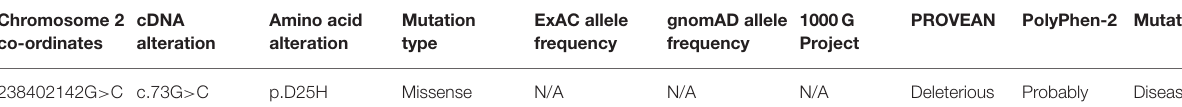
TABLE 1 | Effects of novel MLPH mutation predicted using in silico